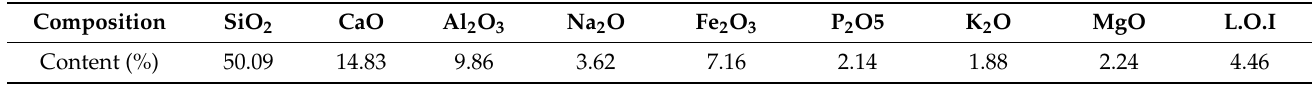
Figure 1. MSWI particle size distribution. Table 1. The main chemical composition of the MSWI